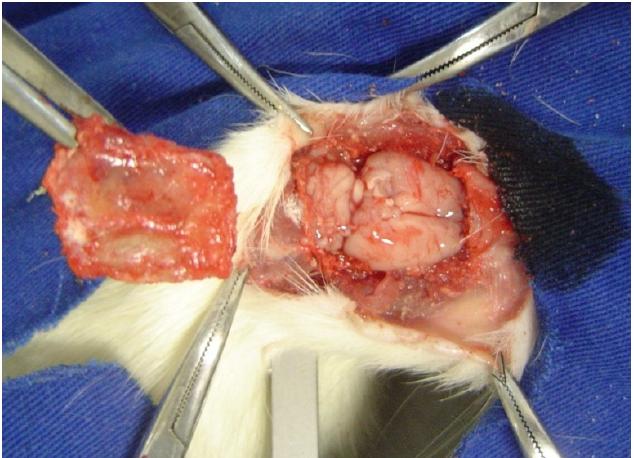
FIGURE 5 - Biopsy collection for histological